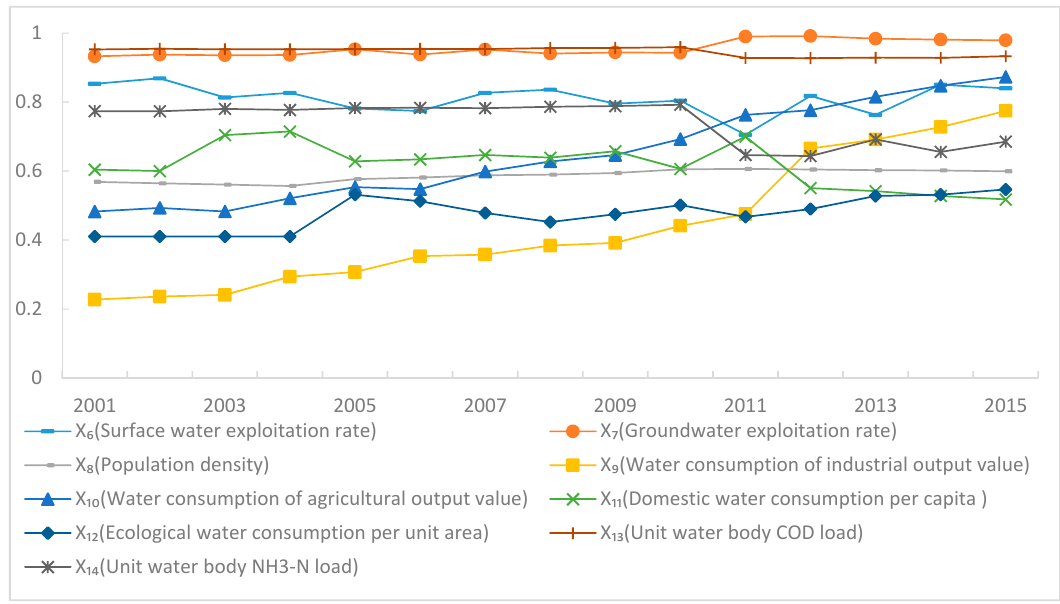
Figure 5. Changes in HAI (Human Activity Intensity) indicators of Guizhou Province in 2001–2015.